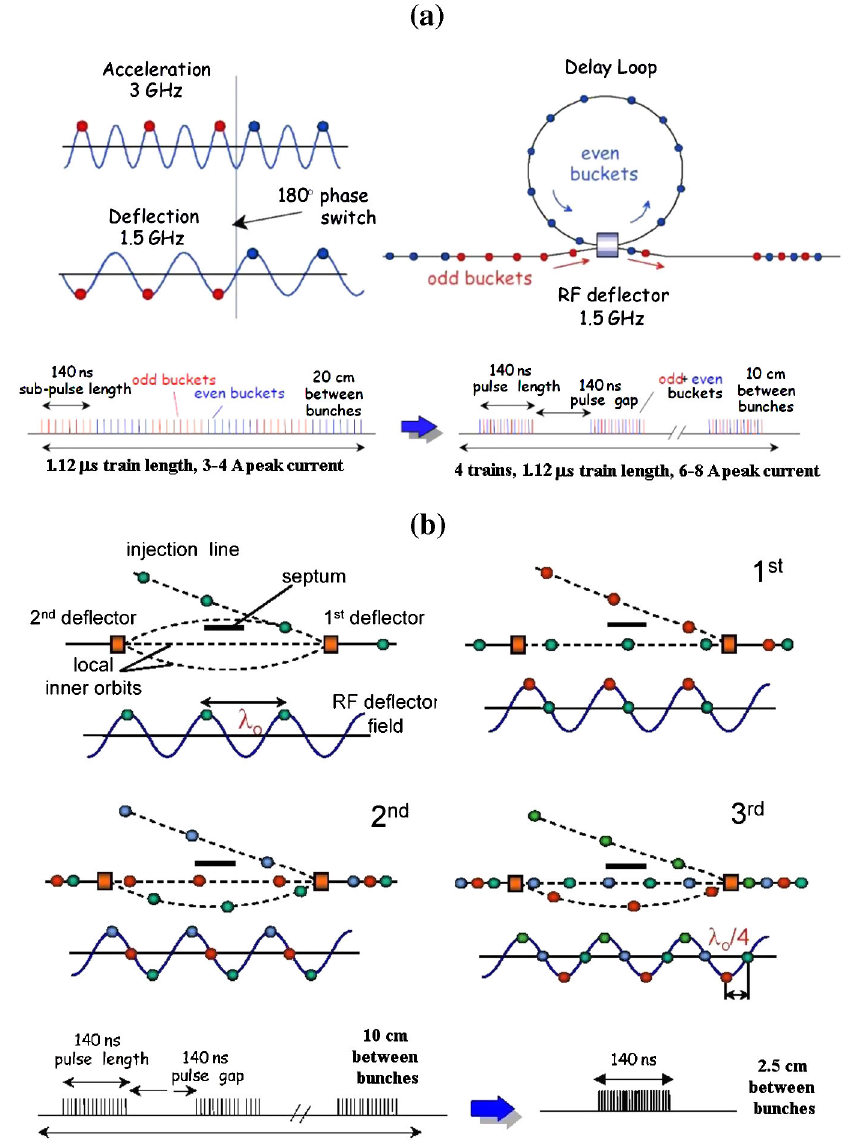
FIG. 2. (a) Sketch of the bunch frequency multiplication in the DL (a) and in the CR (b).